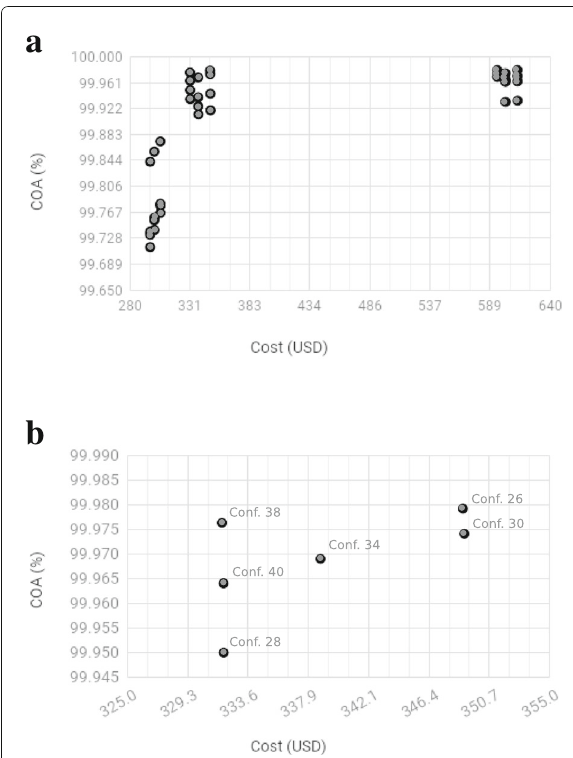
Fig. 7 Ranking of the configurations generated for the first case scenario. a Overview of all ranked configurations. b Optimal configurations